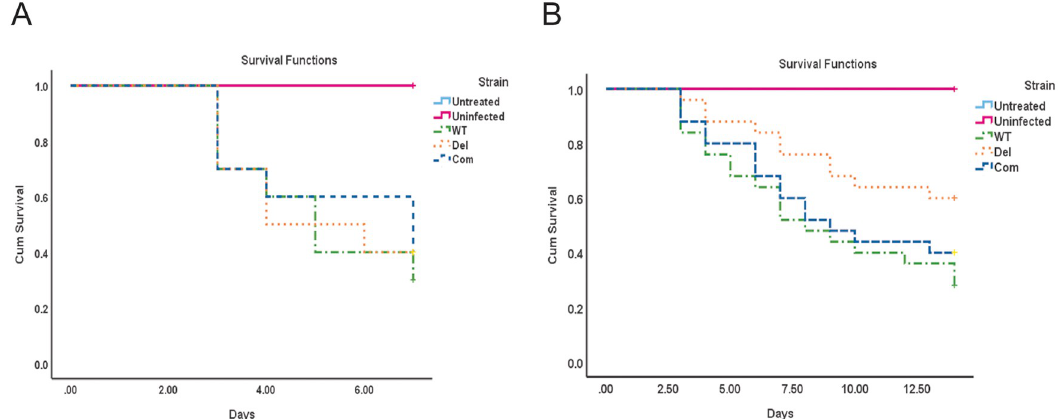
Fig 1. Effect of cpsA in virulence in a murine model. The A . fumigatus wild type (WT), Δ cpsA and Com strains were used to infect female ICR outbred mice. (A) For the neutropenic model, mice were treated with intraperitoneal injection of cyclophosphamide and Kenalog as described in Materials and Methods section. Untreated controls did not receive any treatment and uninfected controls received both cyclophosphamide and Kenalog treatment but not fungal spores. Post infection mice were observed three times daily for first five days and 5 times on day six and seven. Presented data is the result of single experiment (N = 10 total for each group). (B) For the non-neutropenic model, mice were treated only with Kenalog, one day prior to the infection. Untreated controls did not receive Kenalog treatment, and uninfected controls received the Kenalog treatment but not fungal spores. Mice were monitored for survival for 14 days. Statistical analysis was done using IBM SPSS statistics 25. Presented data are the combined results of two independent experiments (N = 25 total for each